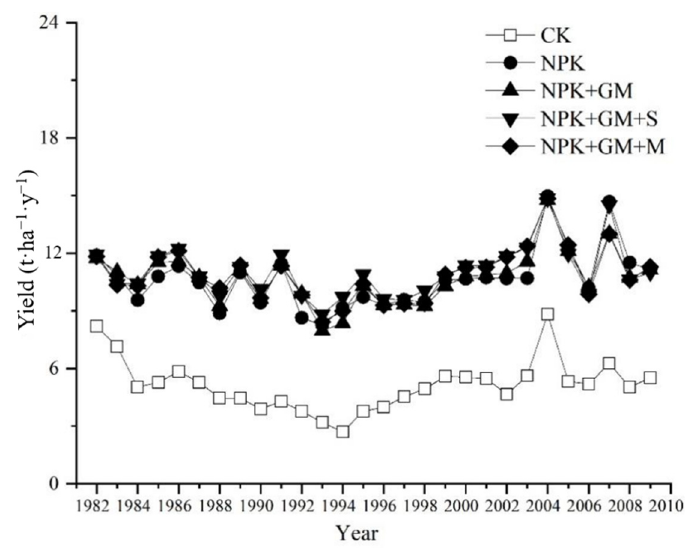
Figure 1. Profiles of temporal variation in double-season rice yield.